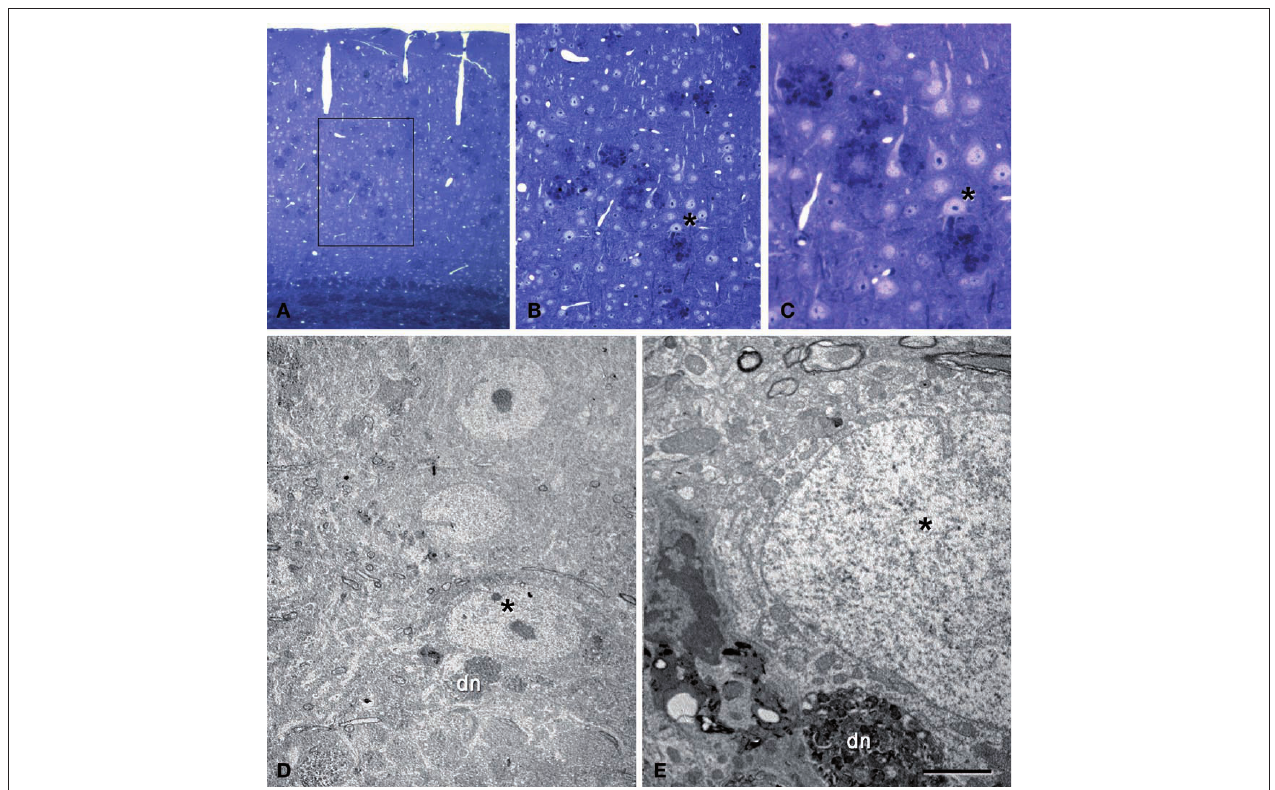
FIGURE 8 | Correlative light and electron microscopy photomicrographs of plaques from the neocortex of an APP/PS1 transgenic mouse. (A–C) Photomicrographs of a 2-µm thick semithin plastic section stained with 1% toluidine blue showing plaques in the neocortex of an APP/PS1 transgenic mouse. (B,C) are successive higher magnifi cations of the boxed area in (A) . (D) Low-power